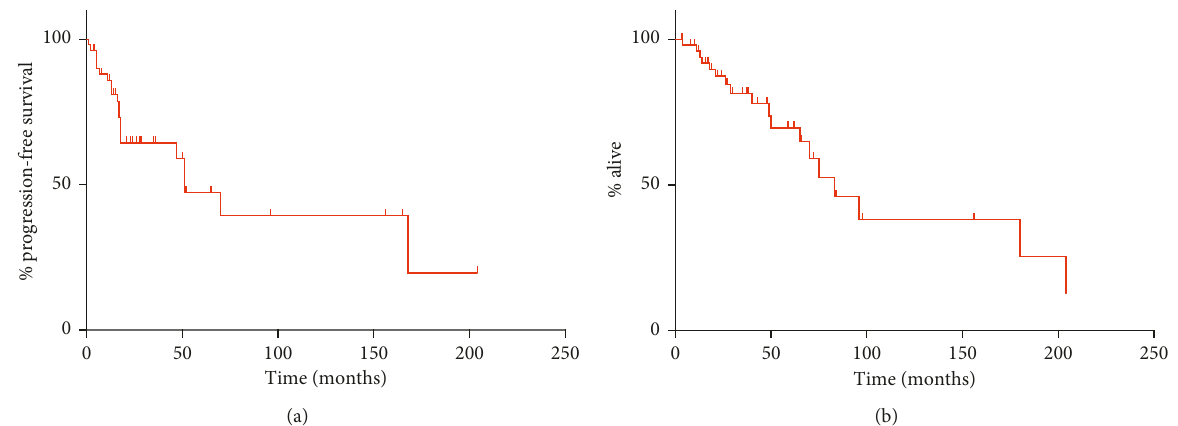
Figure 2: Long-term survival outcomes documented in cases of spontaneous regression of HCC that were treated nonsurgically, based on cases appearing in the English literature. (a) Kaplan–Meier curve, progression-free survival. (b) Kaplan–Meier curve, overall